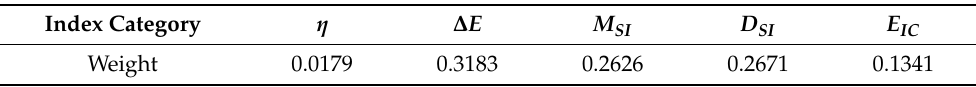
Table 8. Judgmental weight of TPSF.